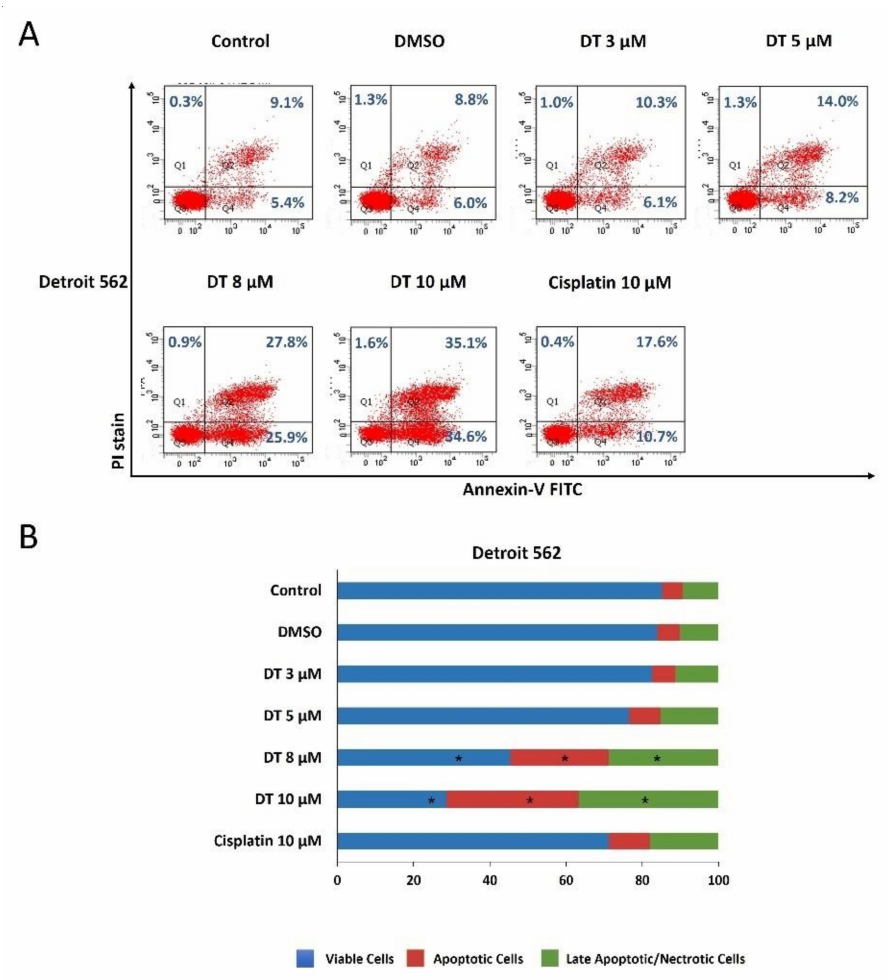
Figure 2. DT-induced apoptosis in Detroit 562 cells. ( A ) Detroit 562 cells were treated with DMSO or DT (3, 5, 8, and 10 µ M) for 24 h, and the percentages of viable cells (annexin V( − )/PI( − )), apoptotic cells (annexin V(+)/PI( − ), and late apoptotic/necrotic cells (annexin V( − )/PI(+) and annexin V(+)/PI(+)) were determined through annexin V/PI staining followed by flow cytometric analysis. ( B ) The distribution of viable, apoptotic, and late apoptotic/necrotic cells after DT treatment was calculated from the means from three independent experiments. * indicates a statistically significant difference compared with untreated control